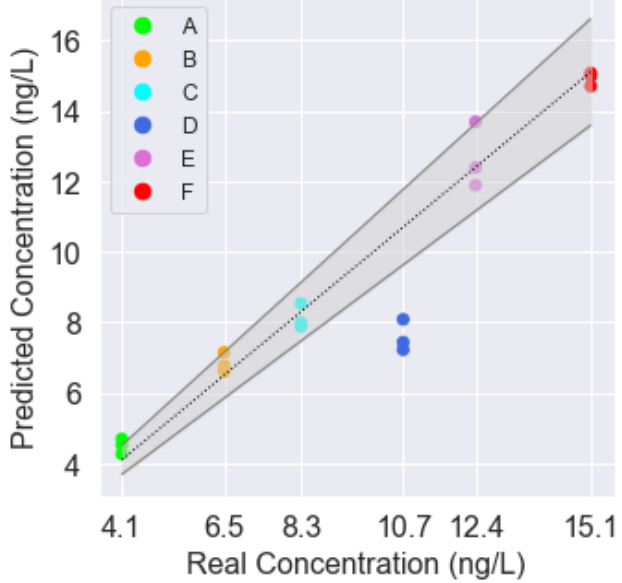
Figure 10. Results of the prediction model.